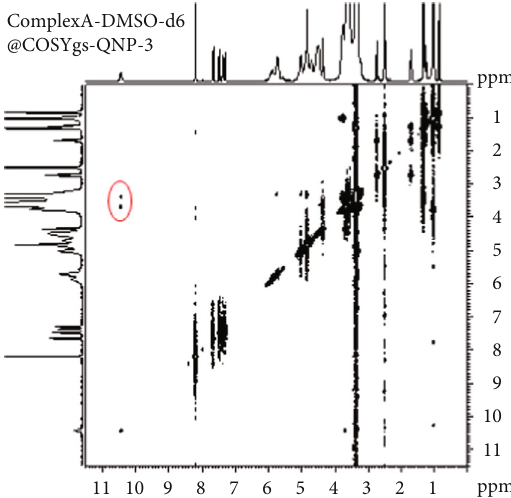
Figure 8: The 2D NMR spectrum of the complex